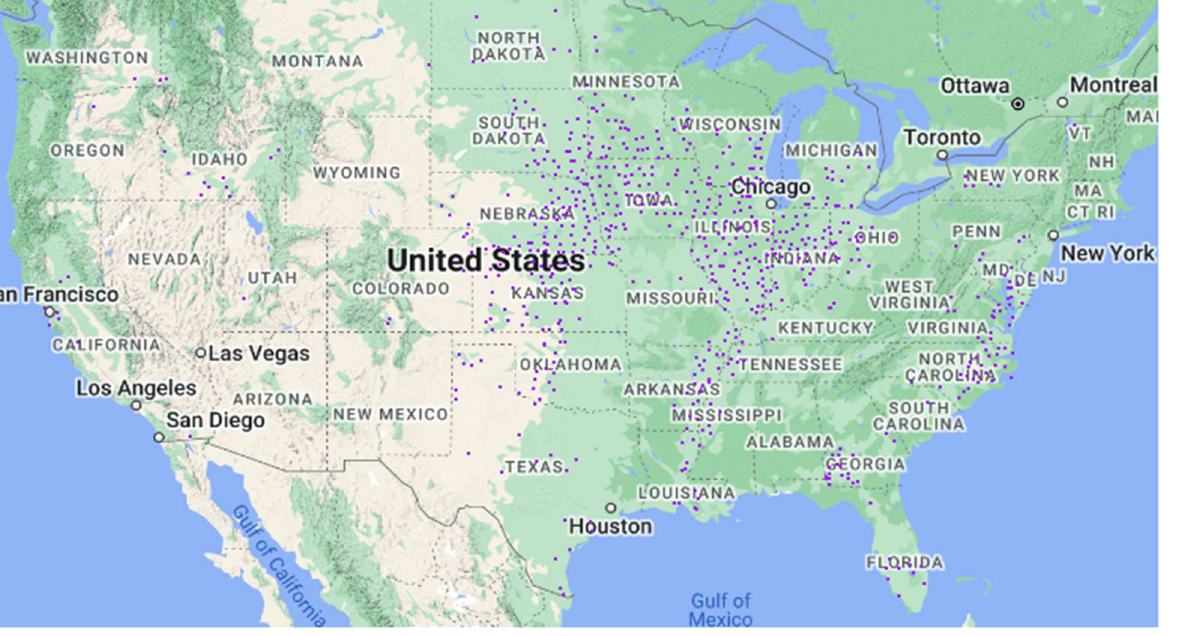
Figure 5. Cluster 3 (690 counties from 37 different states).